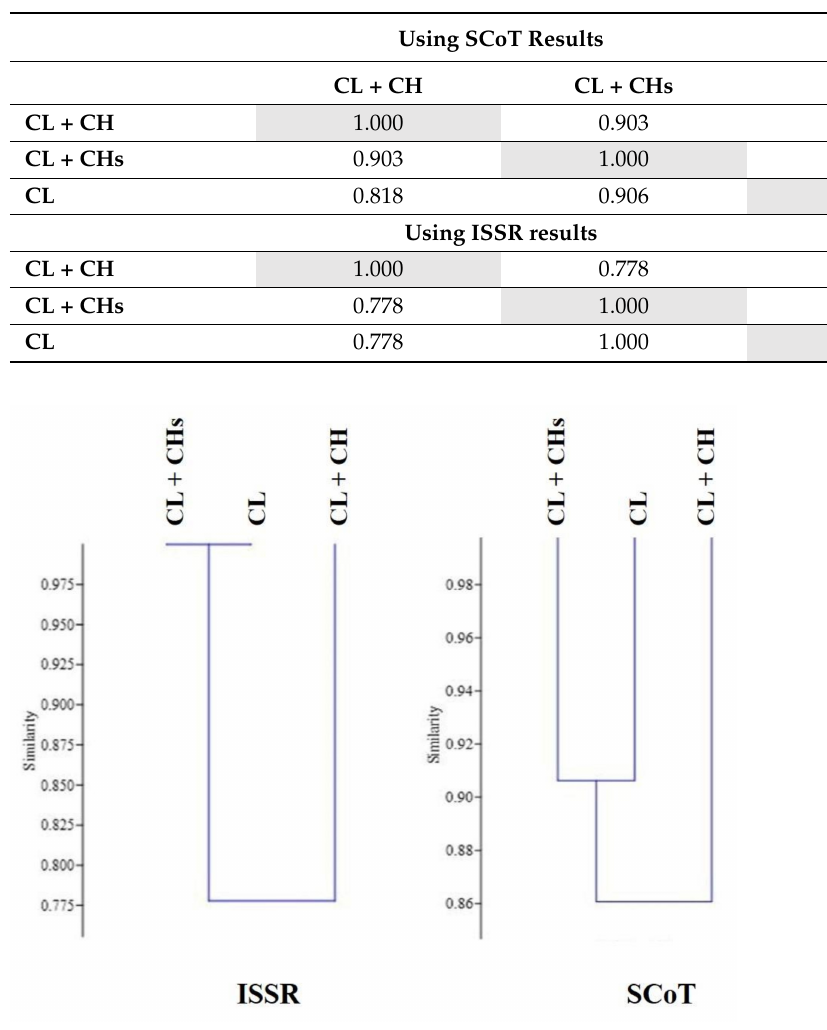
Figure 8. UPGMA dendrograms based on ISSR and SCoT